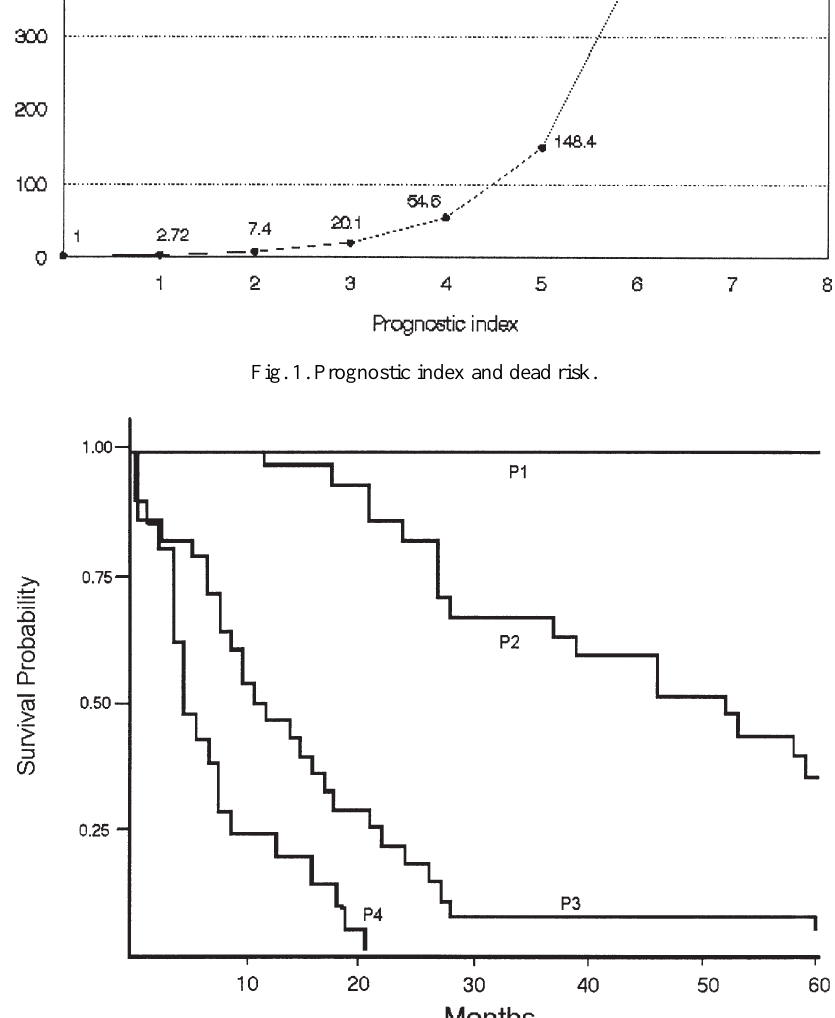
Fig. 2. Survival analysis for prognostic index